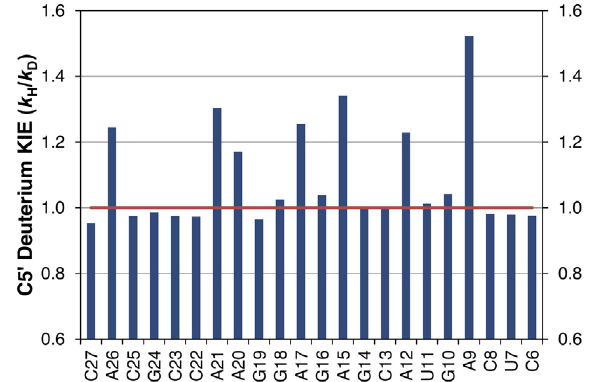
Figure 17. Deuterium kinetic isotope effects calculated by taking the ratio of the cleavage integral of the nondeuterated to the deuterated RNA sample at each residue (for example, the experiment shown in Figure 16). Peak integrals were calculated using the SAFA software package. Signi fi cant deuterium kinetic isotope effects ( k H / k D > 1, above red line) are seen only at the adenine residues, which were deuterated at the 5 ′ position of the